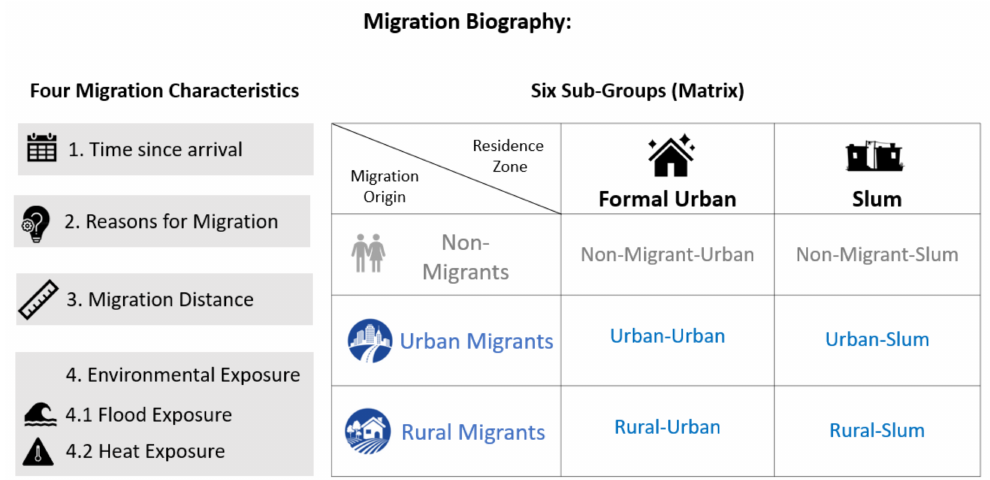
Figure 3. Explanation of migration biography including four migration characteristics and six sub-groups from